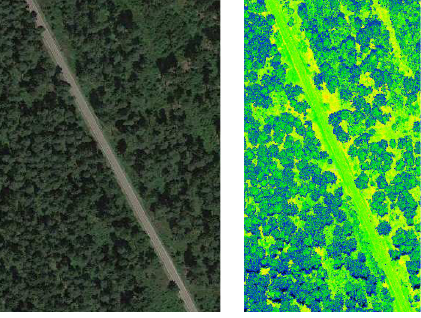
Figure 5: Classification of reference waveforms Figure 6: Asphalt road in aerial photo (left) and laser scanner point cloud